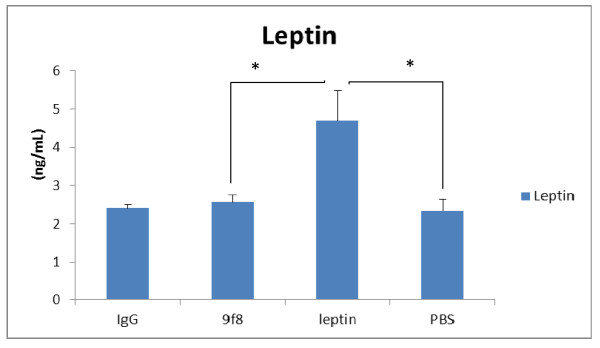
The plasma levels of leptin were significantly higher in leptin group compared to all other groups of mice while there was no significant difference between other groups. * (p < 0.05).